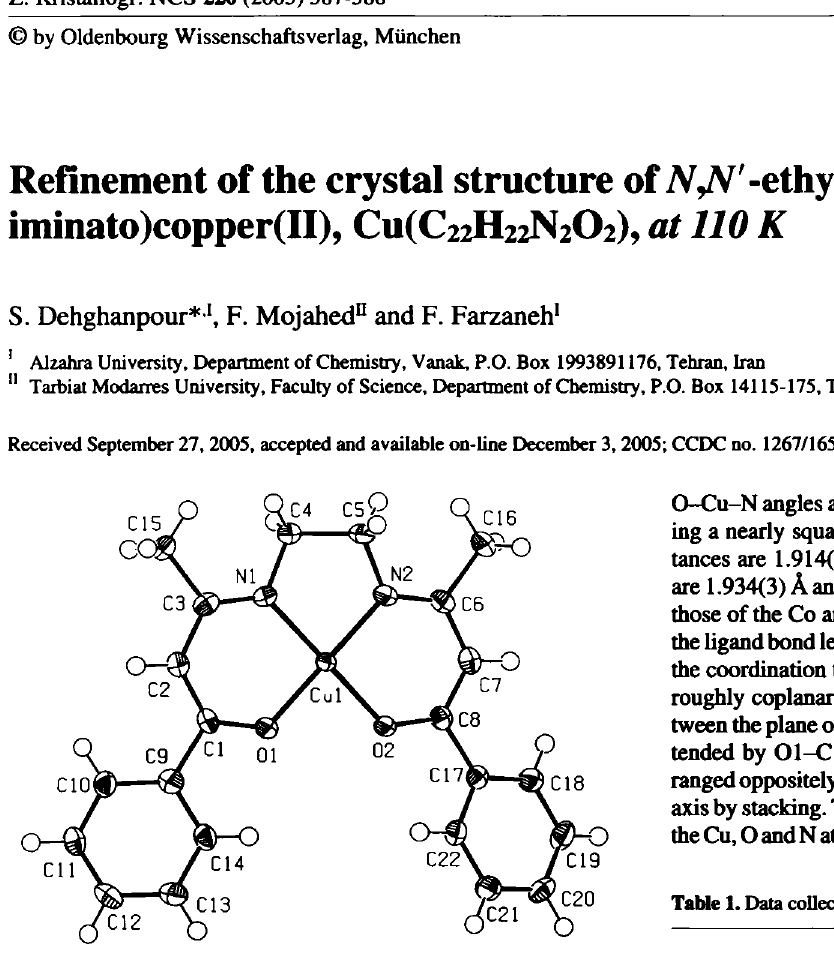
Table 1. Data collection and handling.